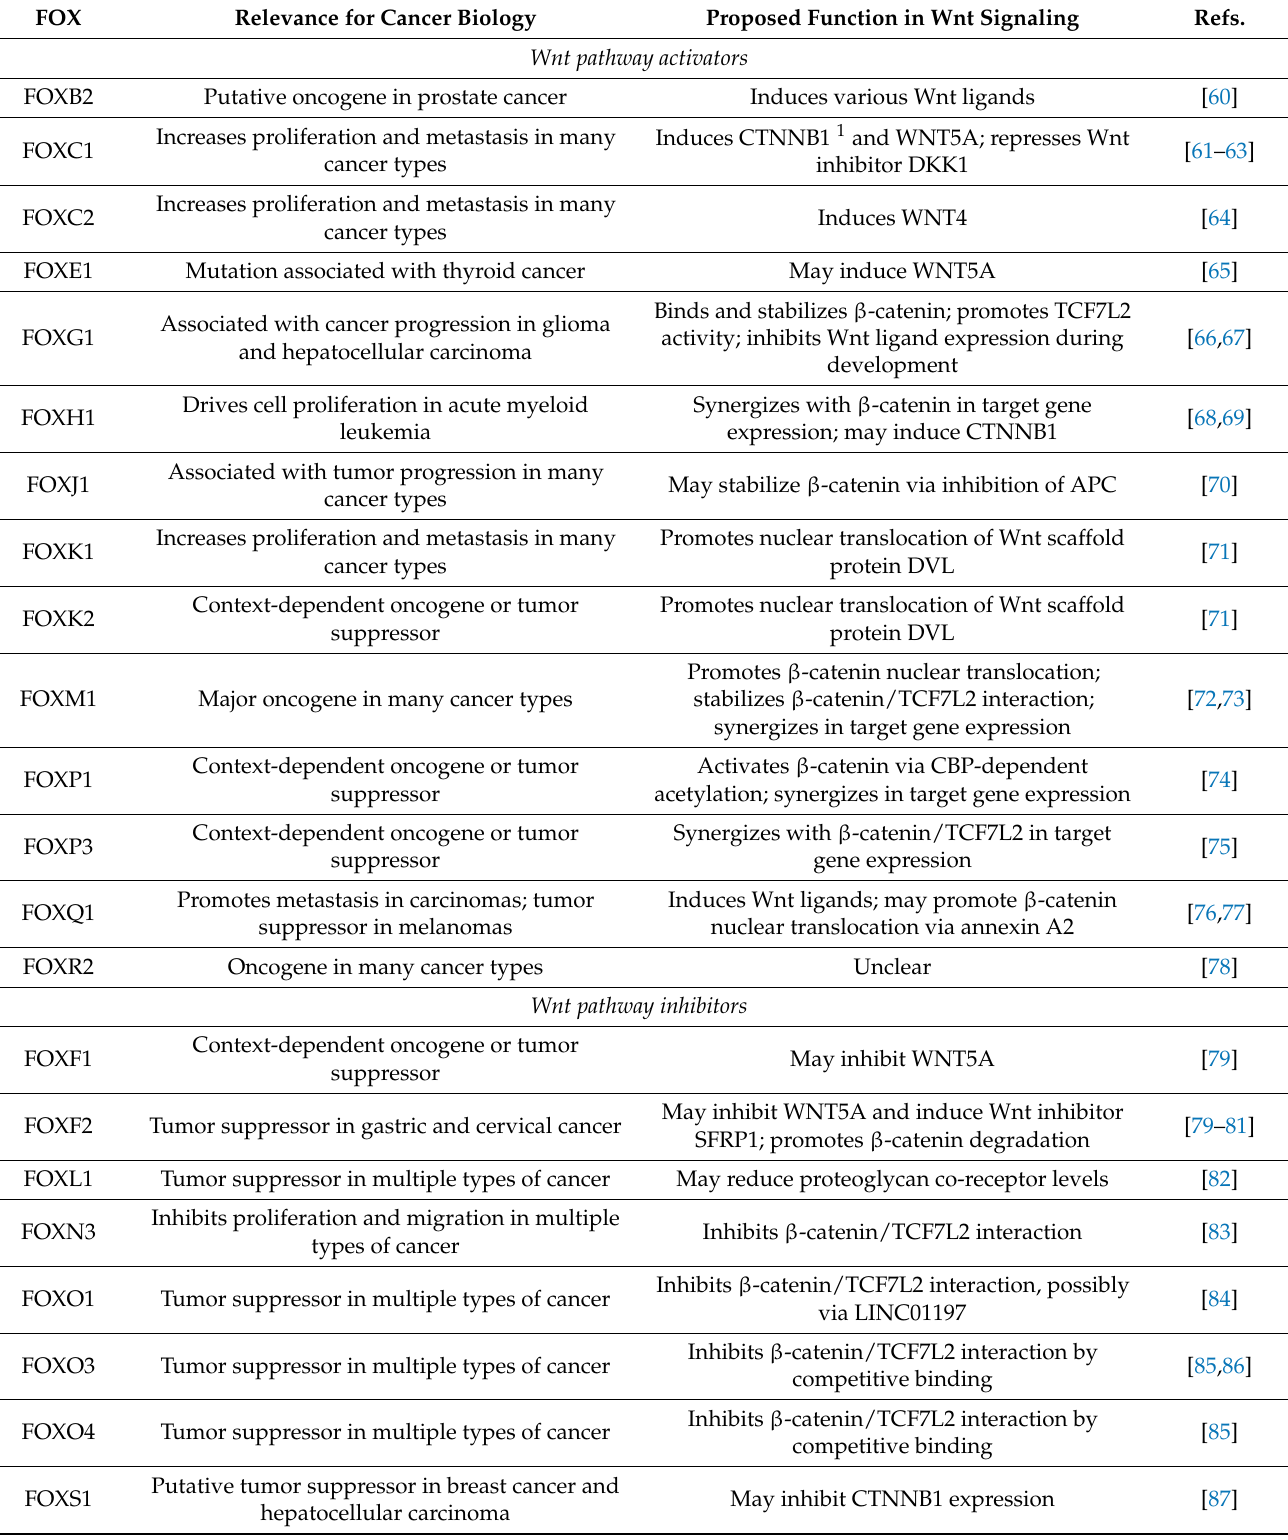
Table 1. Overview of FOX transcription factors linked to both cancer biology and Wnt signaling.